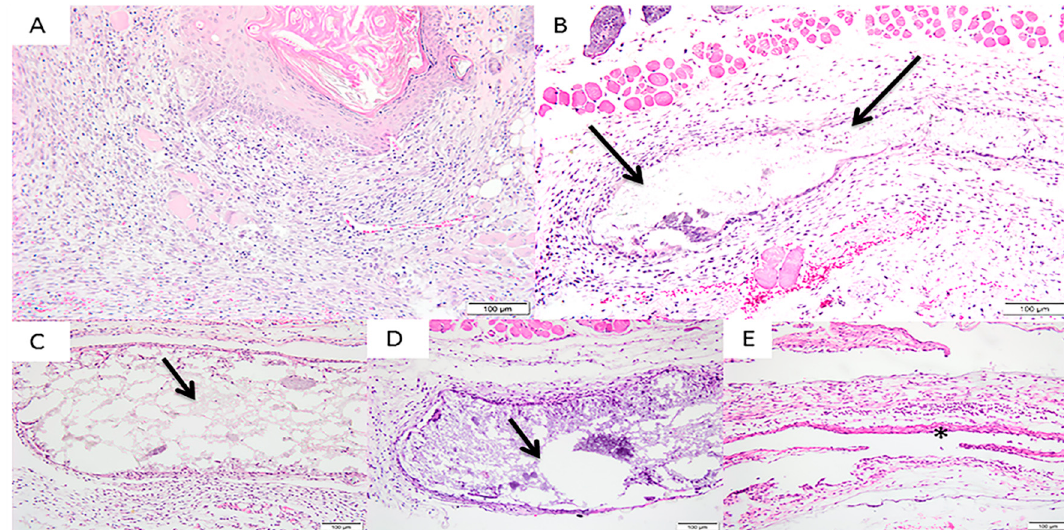
Figure 5. Photomicrographs of the experimental groups after 7 days of membrane implantation in the connective tissue. ( A ) Group 1 (Sham): moderate presence of polymorphonuclear cells and absence of multinucleated giant cells and macrophages; ( B ) Group 2 (200 µm): moderate infiltration of lymphocytes, macrophages and multinucleated giant cells limiting the implanted area; ( C ) Group 3 (500 µm): moderate infiltration of lymphocytes and macrophages and a discrete infiltration of plasm cells and multinucleated giant cells; ( D ) Group 4 (700 µm): moderate presence of lymphocytes, plasm cells and macrophages and a discrete polymorphonuclear infiltration; ( E ) Group 5 (Pratix ® ): moderate presence of lymphocytes, macrophages and polymorphonuclear infiltration. Observe the integrity and the presence of fragment-free membranes in all groups. Arrow corresponds to the implanted membrane; Asterisk corresponds to the Pratix ® membrane site. (Magnification: 200X, Stain: Hematoxylin and Eosin).